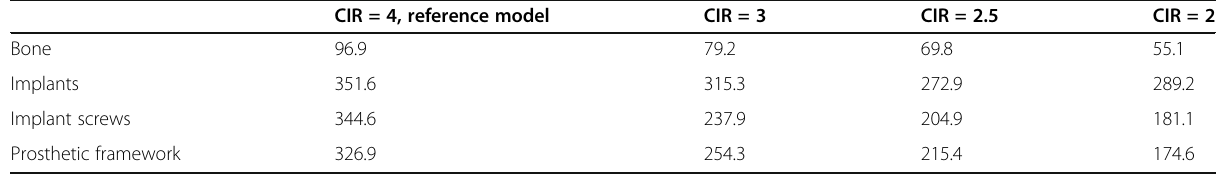
Table 6 Evolution of the stresses (MPa) predicted in the FEA when the CIR decreased by decreasing the prosthetic height and maintaining of the implants ’